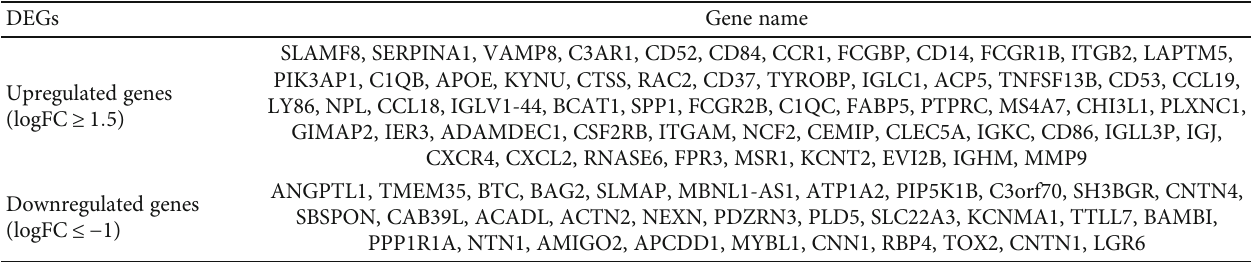
Table 1: The 91 di ff erentially expressed genes were identi fi ed in AA samples compared to EA samples. (The di ff erentially expressed genes were ranked from the smallest to the largest of adjusted p